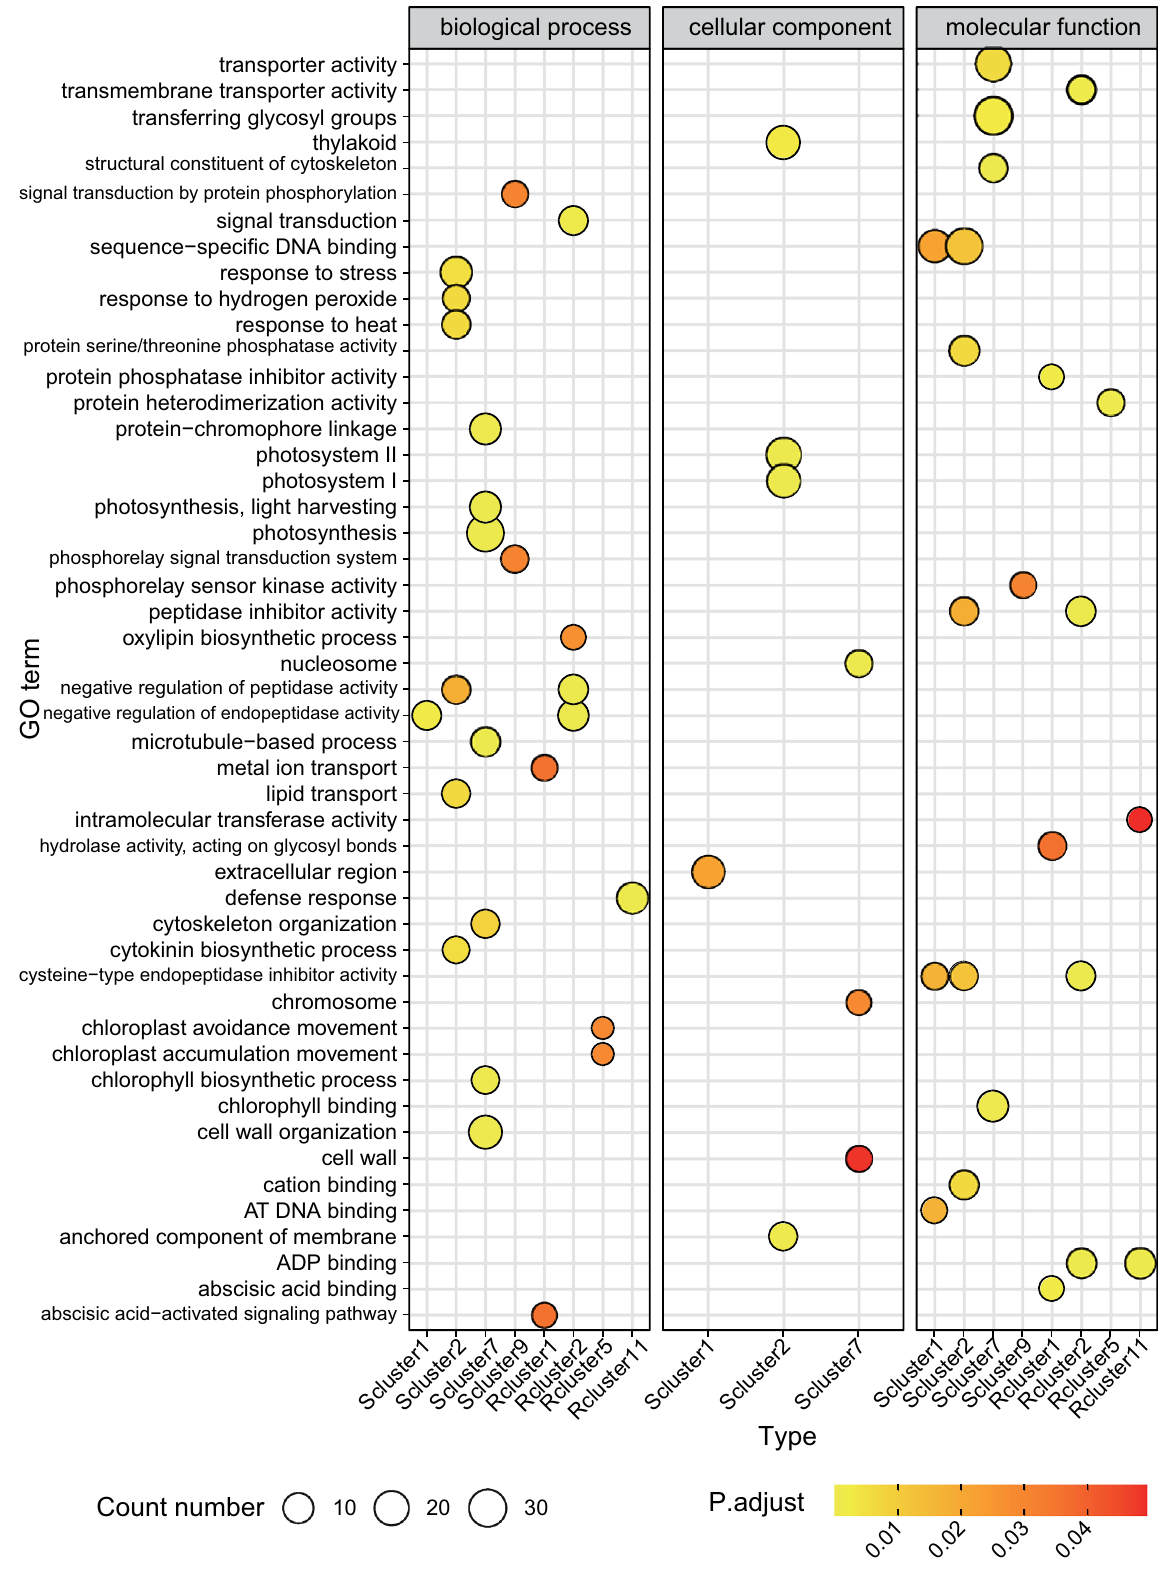
Figure 4. GO enrichment analysis of 8 significant clusters of DEGs associated with disease resistance and susceptibility (only the top 15 GO terms in each cluster are shown). The abscissas Scluster1 and Rcluster2 represent cluster 1 of susceptible materials (TG-5) and cluster 2 of resistant materials (TG-1) in trend analysis, respectively. Count number means the genes count of the GO term. The P. adjust means the adjust P-value of GO enrichment